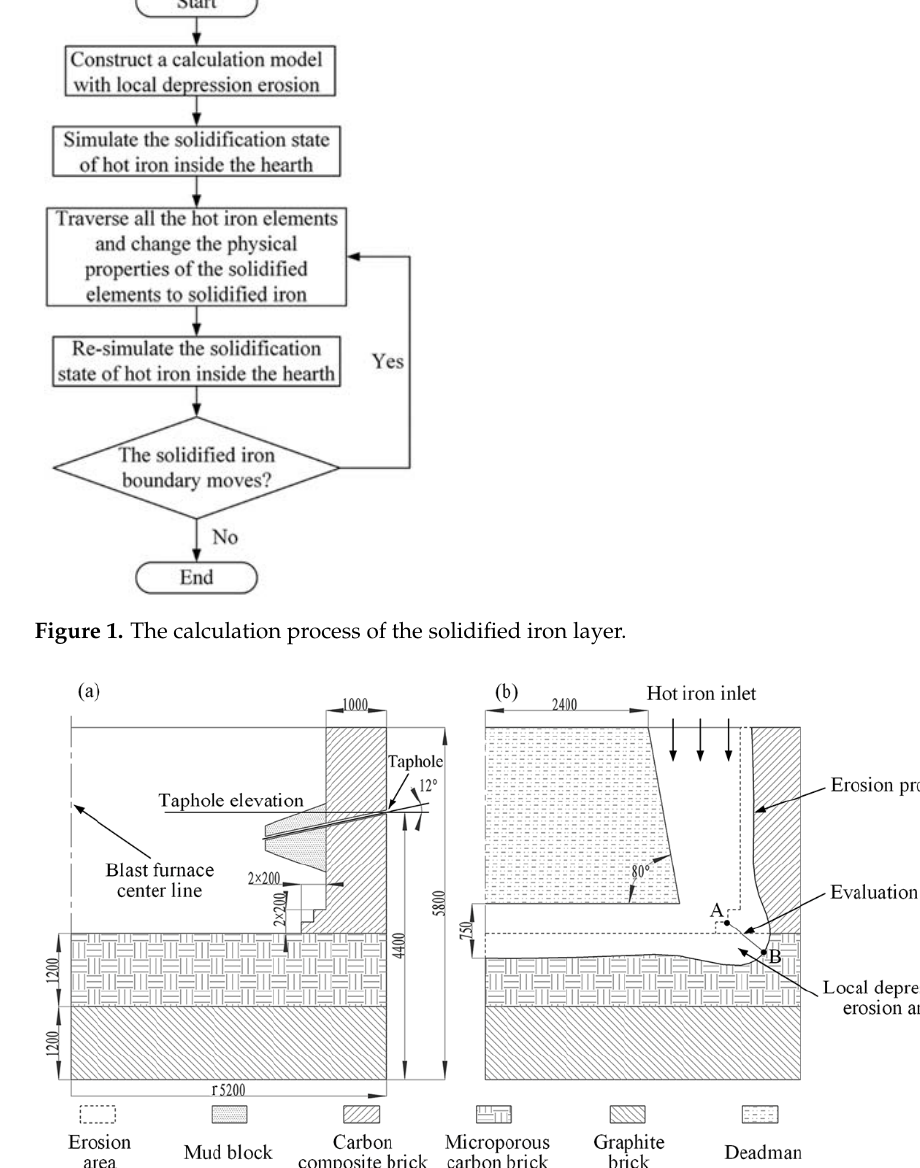
Figure 1. The calculation process of the solidified iron layer.